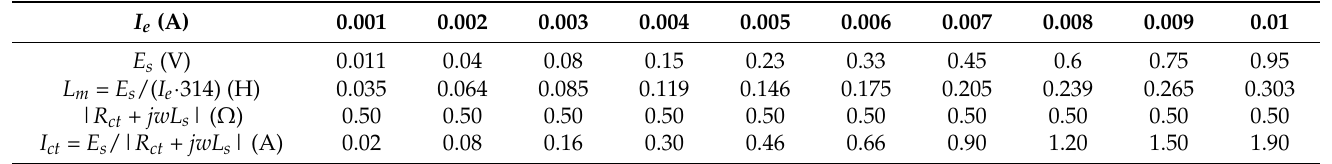
Table 3. Factory data of the saturation magnetic curve.